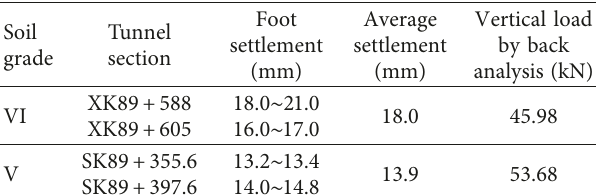
Table 3: Field measurements of tunnel sections with the different soil grades.